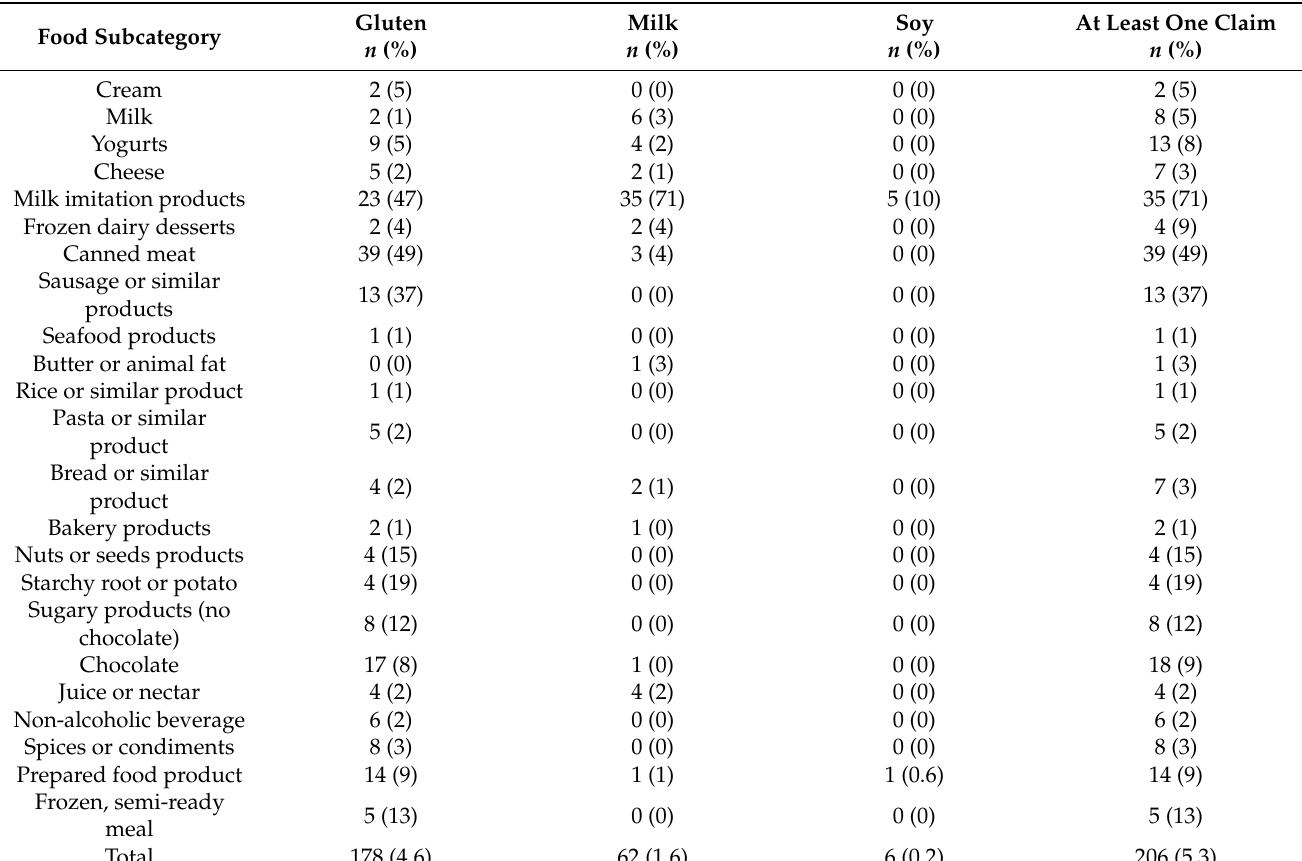
Table 5. Prevalence of the three most commonly used allergen-free claims per food subcategories that include at least one allergen-free